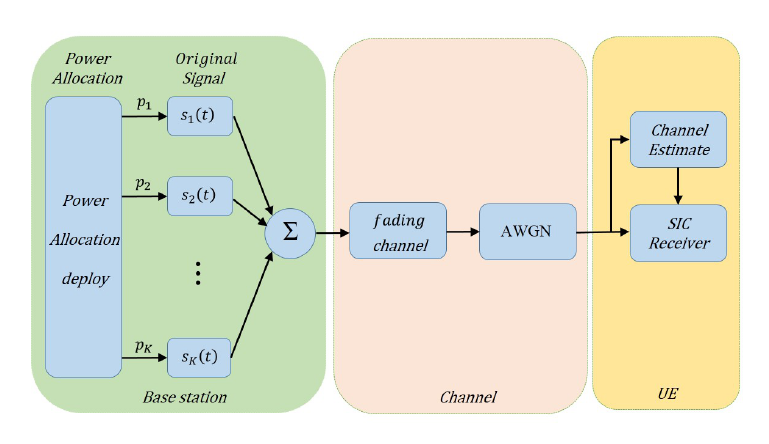
Figure 1. Non-orthogonal multiple access (NOMA) system architecture. AWGN: additive white Gaussian noise; SIC: successive interference cancellation.